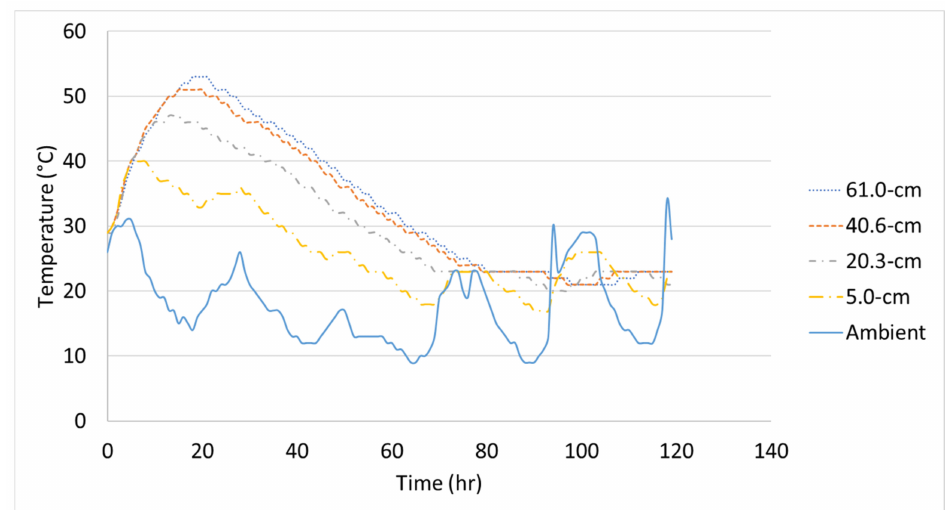
Figure 7. Temperature-time history of Batch 2’s 1.2-m (4-ft) cube.